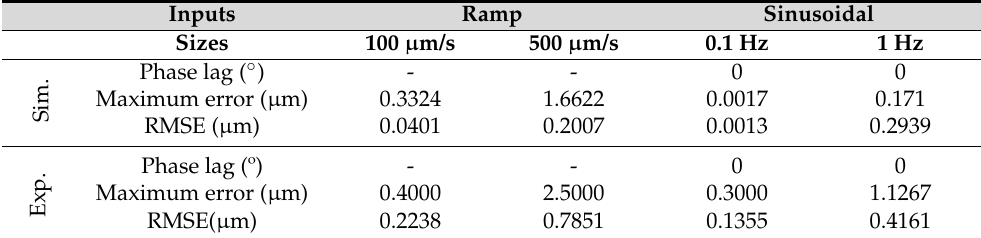
Table 3. Tracking performance of the motor